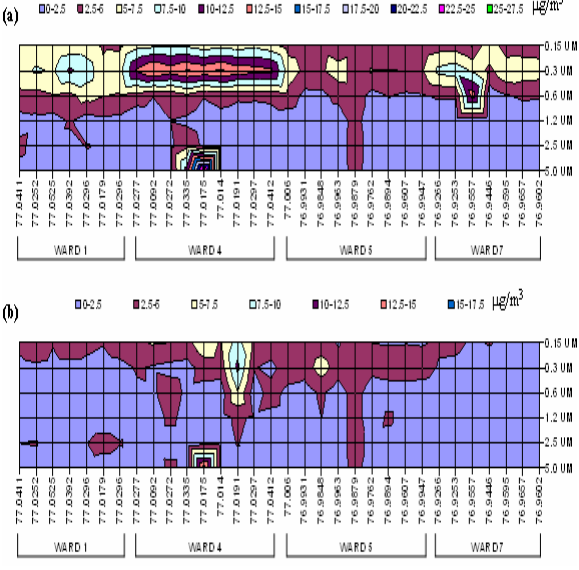
Figure 4: Contour Mapping of (a) Summer IOP and (b) Fall IOP PM